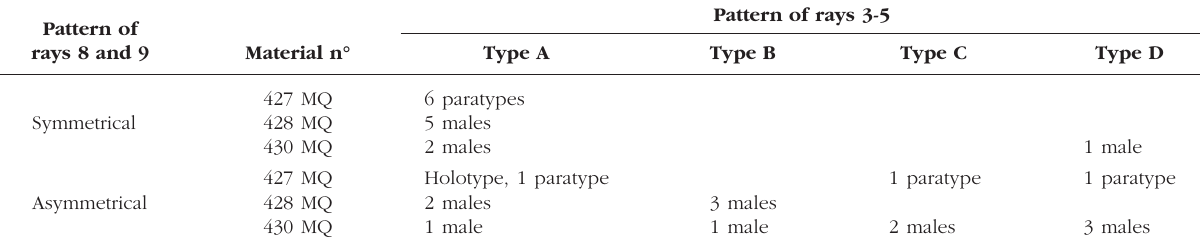
Table I. – The combination of the relative arising of rays 3-5 and the relative distance between their extremities provide four different pat- terns of caudal bursae in Heligmonina wakelini n. sp. These, together with the symmetrical/asymmetrical of rays 8 on the dorsal ray may be considered as infra-specific